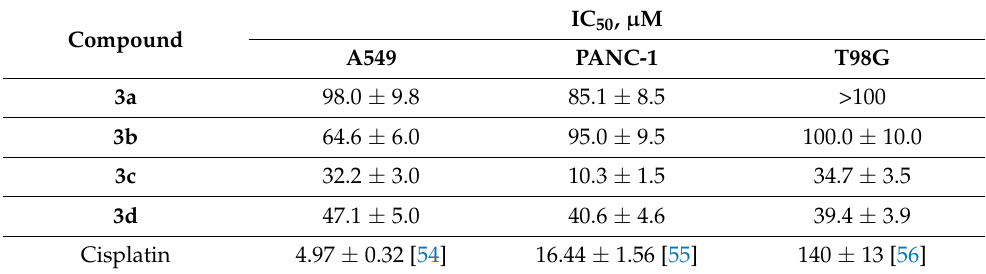
Table 2. The cytotoxic activity of complexes 3a–d and cisplatin as reference compound determined by the MTT assay. The data presented were obtained from three independent experiments, and the values for IC 50 are mean ± SD.